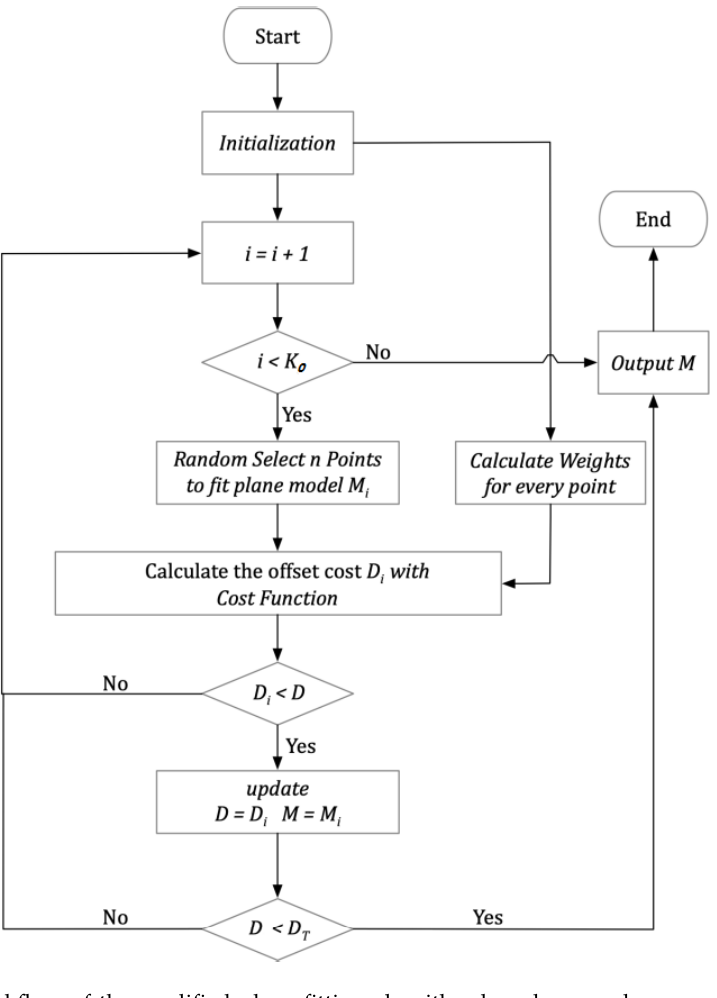
Figure 2. Workflow of the modified plane fitting algorithm based on random sample consensus (RANSAC).